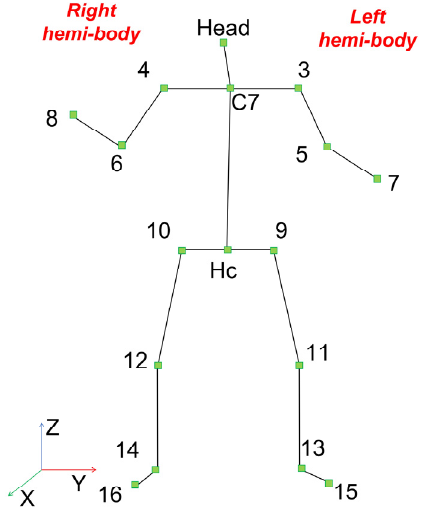
Figure 1. Skeleton with 17